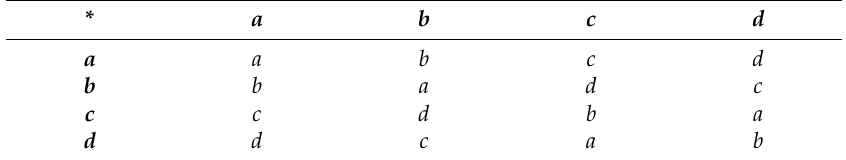
Table 2. The operation * on N